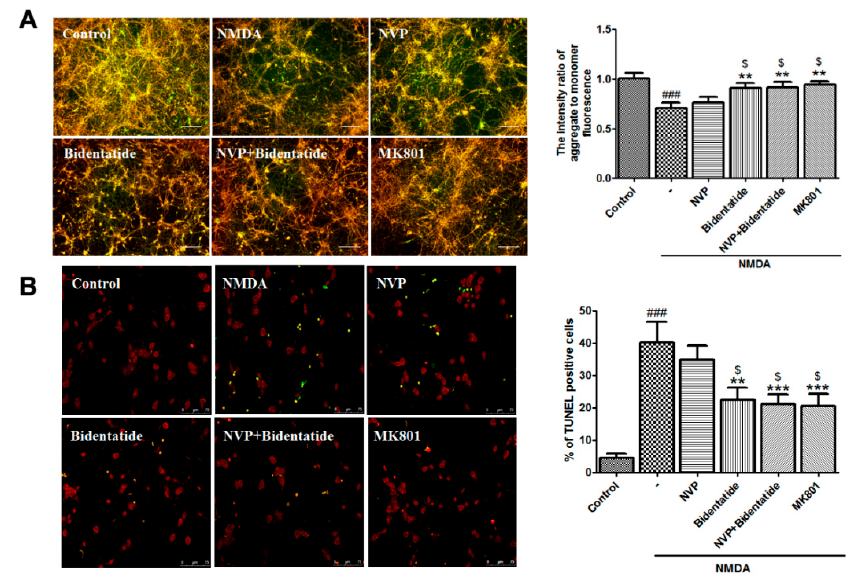
Figure 4. Involvement of NR2B-containing NMDA receptors in anti-apoptosis effects of bidentatide: ( A ) representative fluorescence micrographs of JC-1 staining for (aggregate in red, monomer in green, and the merge in yellow) and bar graph of the fluorescence intensity ratio of aggregate-to-monomer in primary cultured hippocampal neurons upon no treatment, exposure to NMDA alone, pretreatment with NVP-AAM077 (100 nM) for 30 min and then exposure to NMDA, pretreatment with bidentatide (100 nM) for 30 min and then exposure to NMDA, pretreatment with NVP-AAM077 (100 nM) and bidentatide (100 nM) for 30 min and then exposure to NMDA, and pretreatment with 10 μ M MK801 for 30 min and then exposure to NMDA; scale bar, 100 μ m; ( B ) representative fluorescence micrographs of TUNEL staining (PI staining in red, TUNEL-positive staining in green, the merged area in yellow) and bar graph of the percentage of TUNEL-positive cells in primary cultured hippocampal neurons upon different treatments as mentioned above. Yellow indicates merged PI staining (red) and TUNEL-positive staining (green); scale bar, 75 μ m; ### p < 0.001 verses control; ** p < 0.01, and *** p < 0.001 verses NMDA alone; $ p < 0.05 versus pretreatment with NVP-AAM077 plus NMDA.